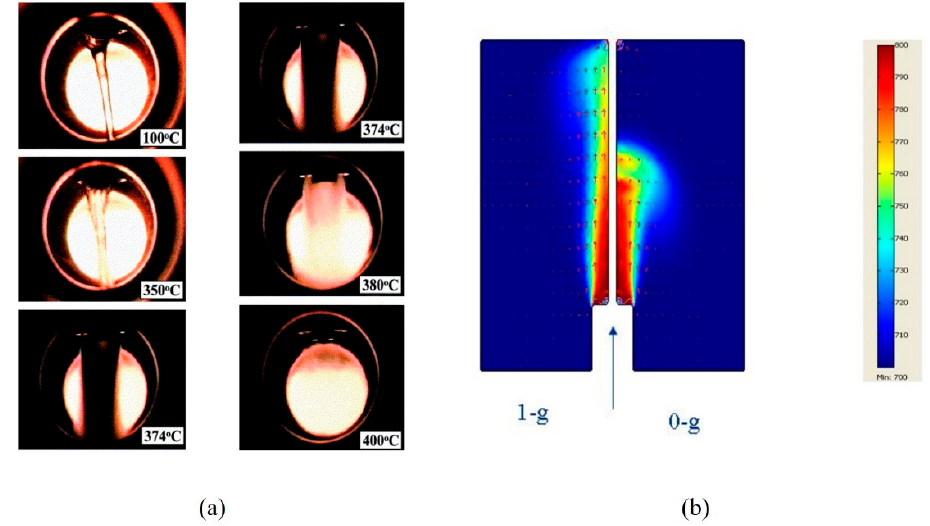
Figure 10. ( a ) Influence of temperature on the water flow at 25 MPa (50 mL min − 1 water and 1 nL min − 1 air) (adapted from [49]); ( b ) Illustration of buoyancy effects showing non-reacting axisymmetric jet of heated fluid injected into the body of cooler fluid (adapted from [59]).